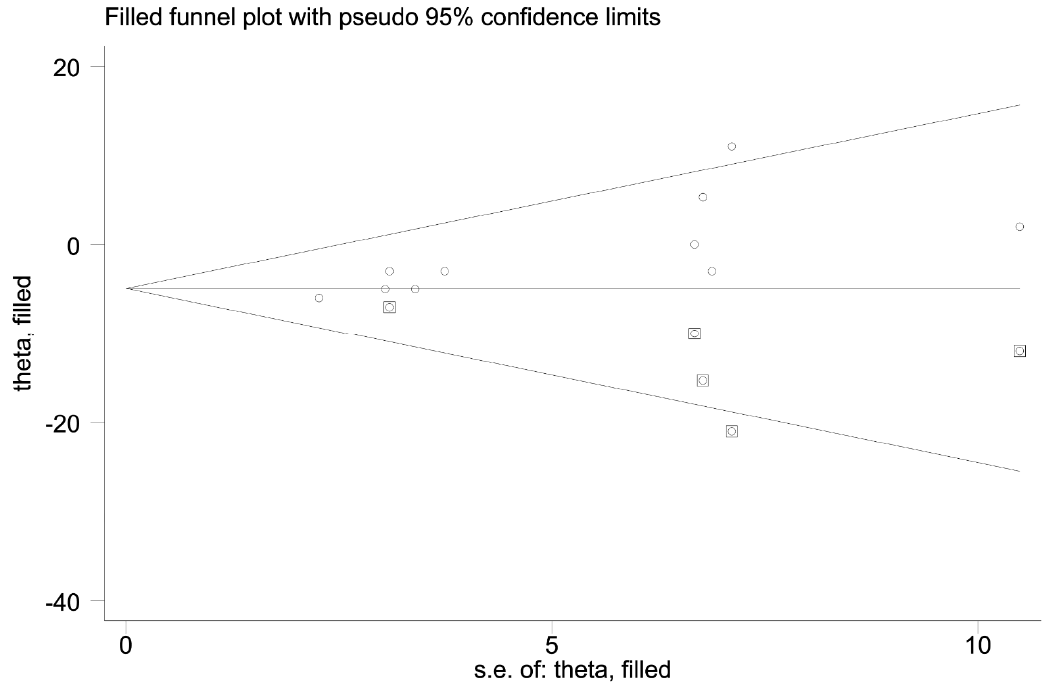
Figure 3. Funnel plot with trim and fill for the effect size of SBP. ( ○ :previous studies; : filled